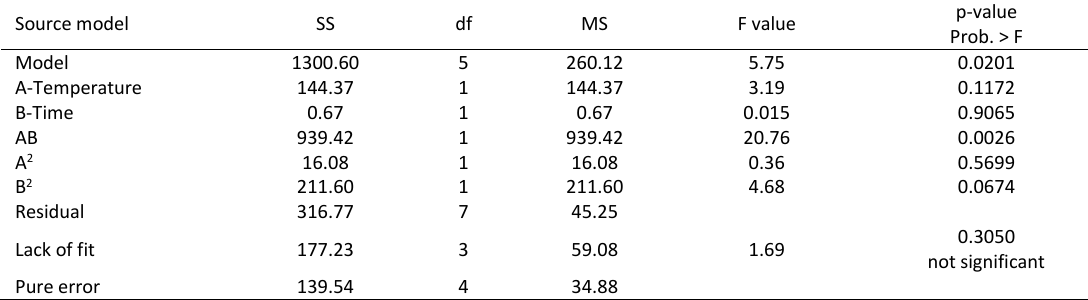
Table 3b: Analysis of variance (ANOVA) for COD removal Source model